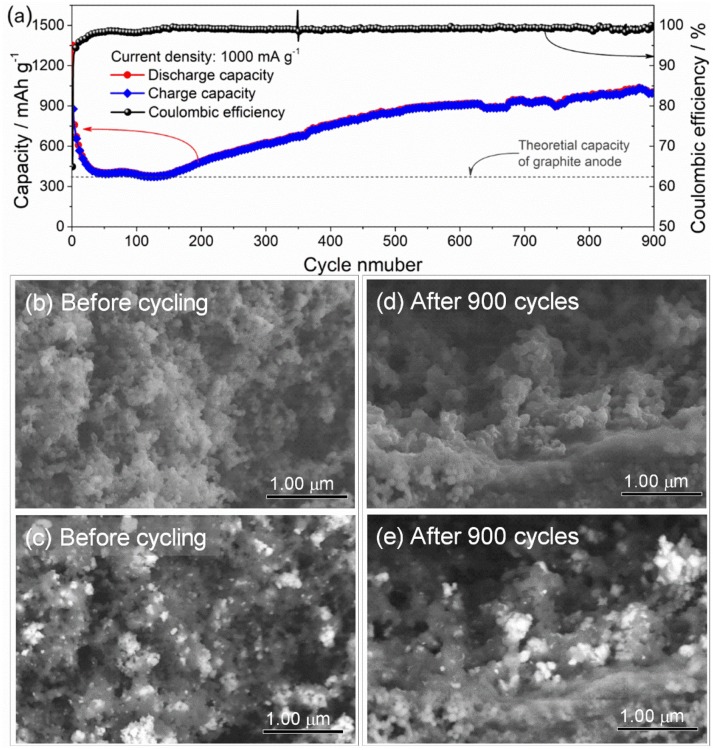
(a) Long-term cycling performance of the ZnFe2O4/α-Fe2O3 nanocomposites electrode at a current density of 1000 mA g-1. SEM images of the ZnFe2O4/α-Fe2O3 nanocomposites electrode (b,c) before cycling and (d,e) after 900 cycles. Figures (c,e) are back scattering images of Figures (b,d), respectively.